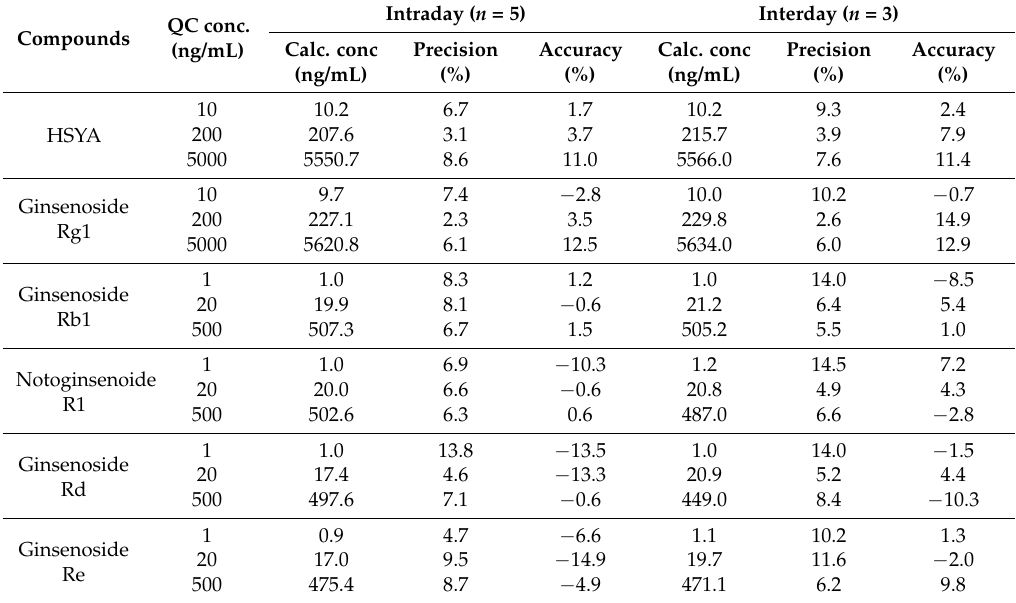
Table 3. Intra-/interday precision and accuracy of six compounds in